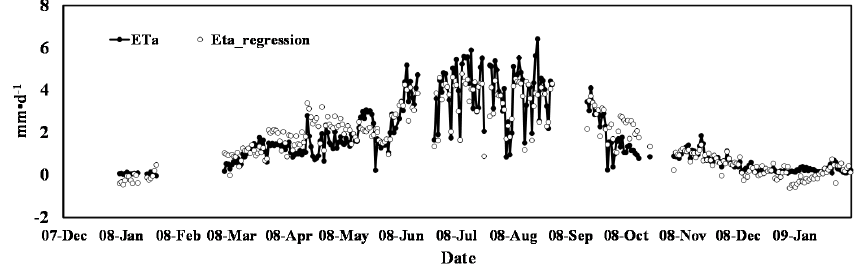
Figure 7. The comparison of the calculated results with the regression results of actual evapotranspiration ( ET a